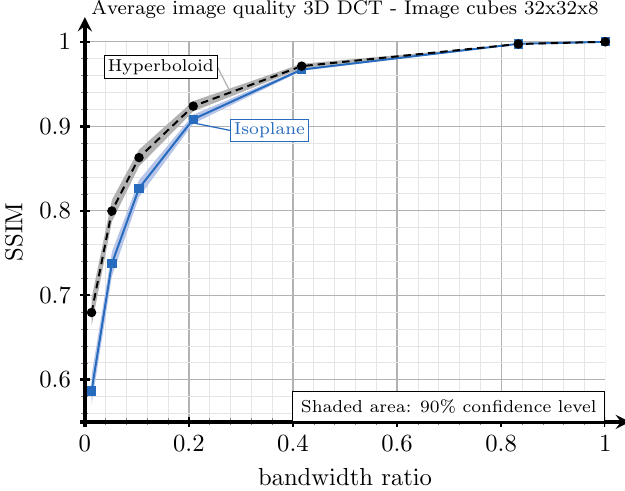
Shaded area: 90% confidence